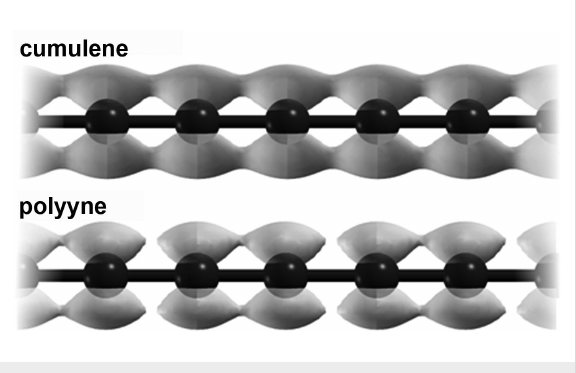
Figure 1: π -Electron distribution in cumulene (top) and polyyne (bottom). Calculation by A. Botello-Mendez and J.-C. Charlier. Reprinted with permission from [23]. Copyright 2013 American Chem- ical Society.